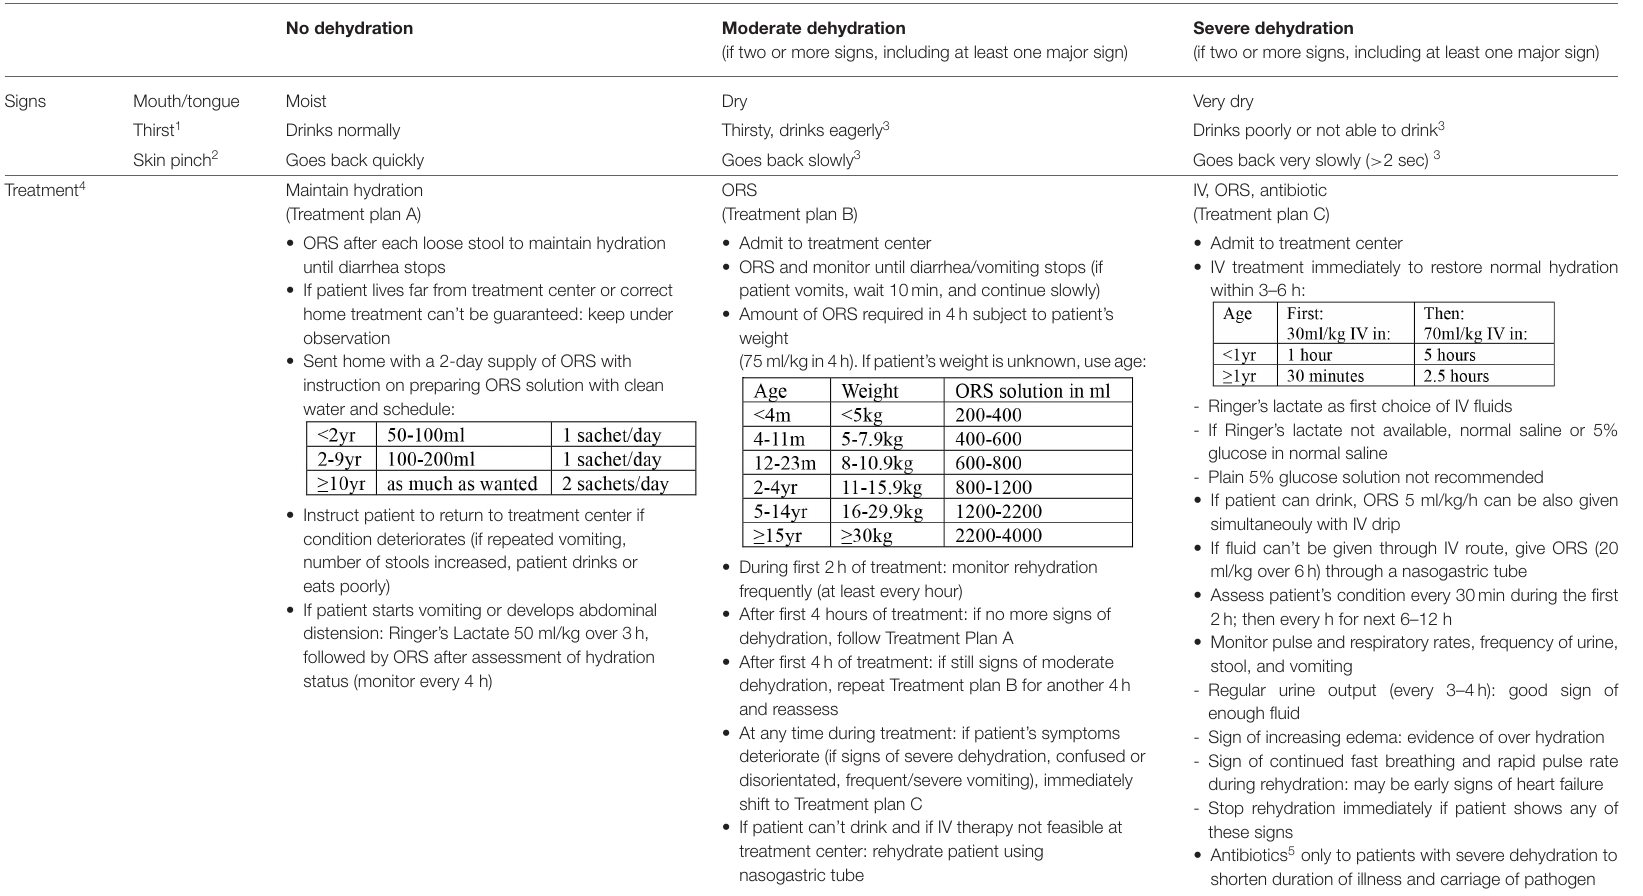
TABLE 4 | Treatment for cholera case management.